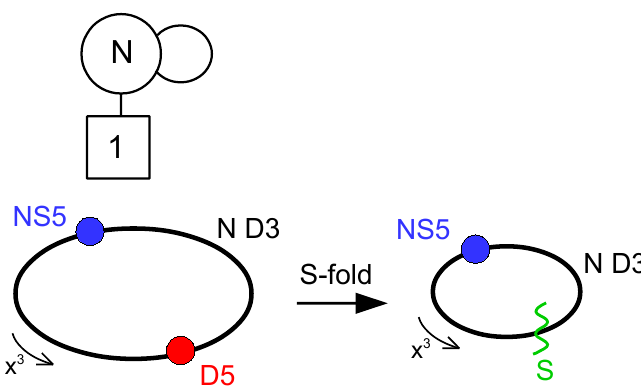
Figure 5 . A mirror quiver of the ABJM theory at level k = 1. The S-quotient of its brane realization leads to the brane realization of the half-ABJM